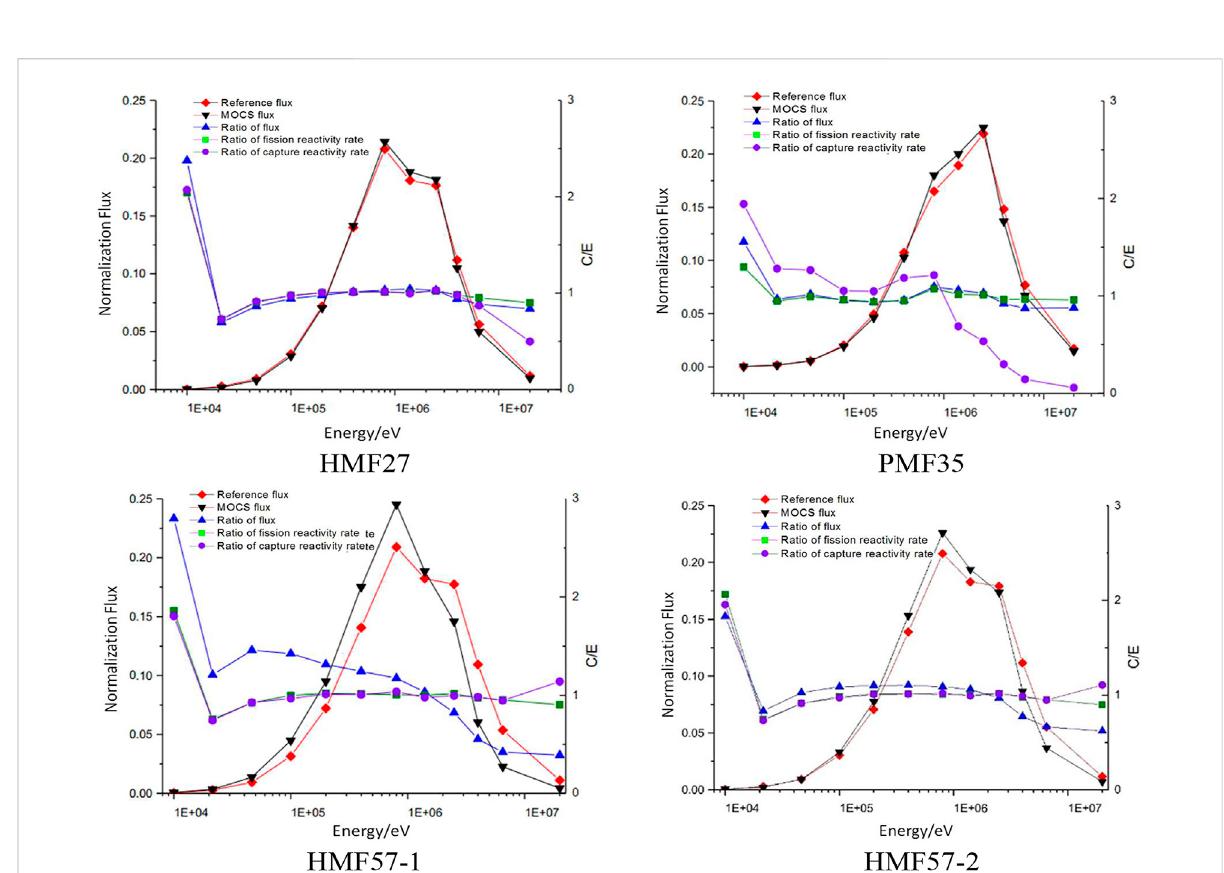
FIGURE 5 Flux and reactivity rate Results of HMF27 and